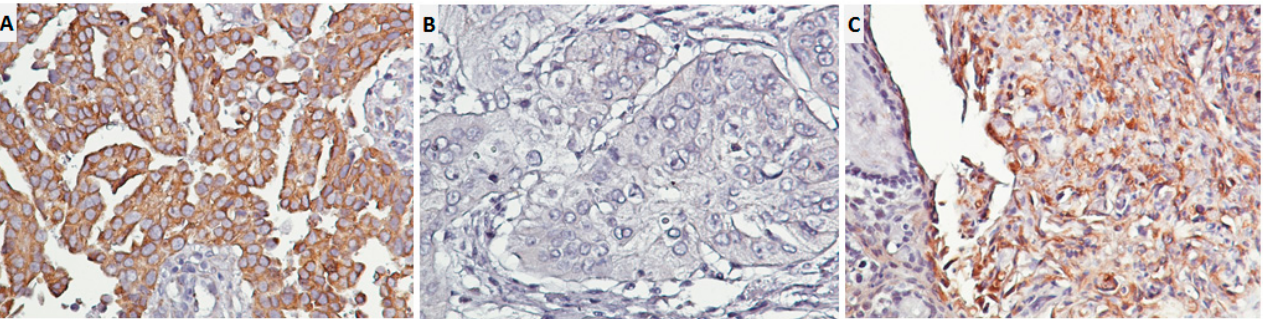
Figure 1. Immunostaining for HPV 16E6/18E6 proteins in lung adenocarcinoma tissues. ( A ) High expression; ( B ) low expression; ( C ) positive control (cervical squamous carcinoma); 400×.